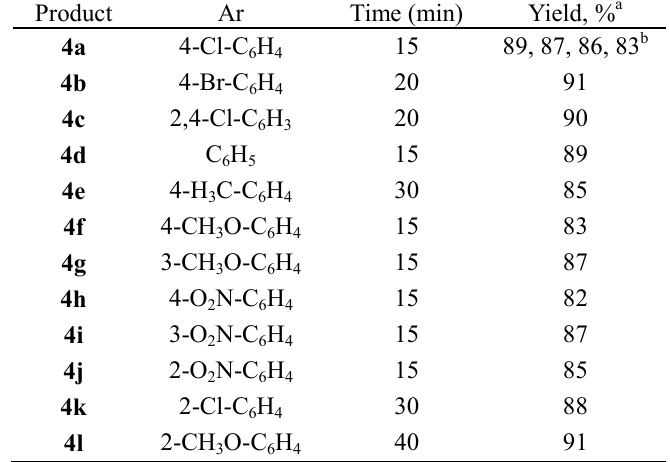
catalyzed synthesis of 12-aryl-8,9,10,12-tetrahydrobenzo[ a ] xanthen-